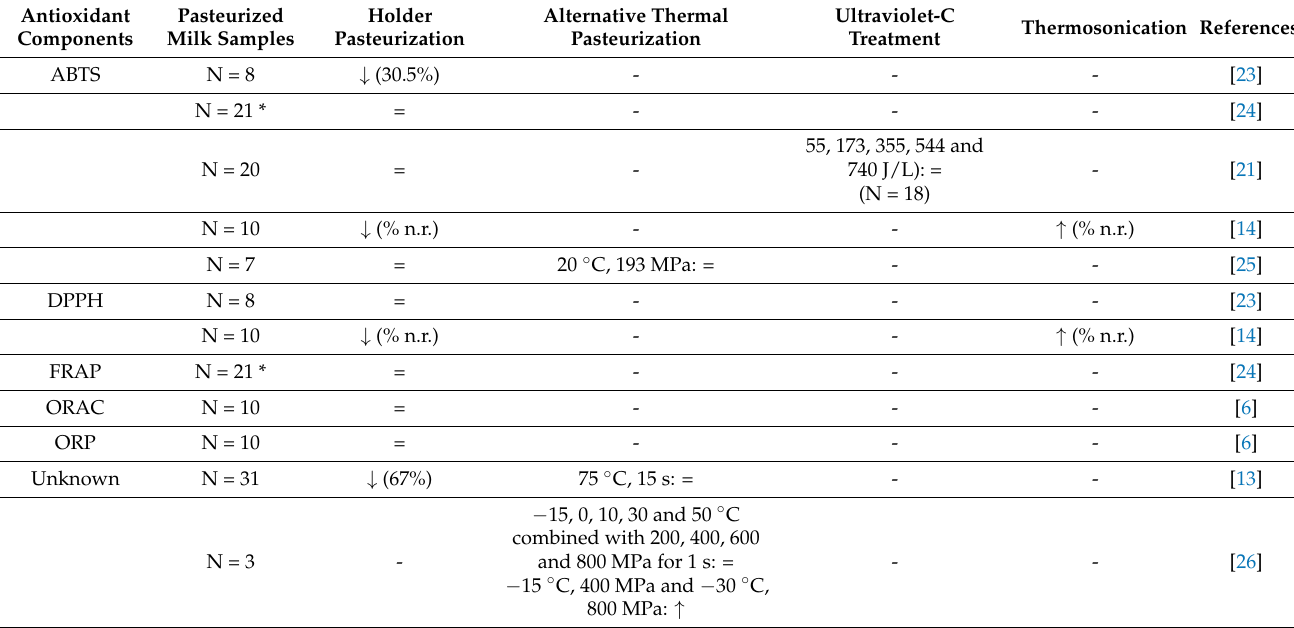
Table 1. Results of different pasteurization methods on antioxidant properties in human milk: total antioxidant capacity. Antioxidant Pasteurized Components Milk Samples